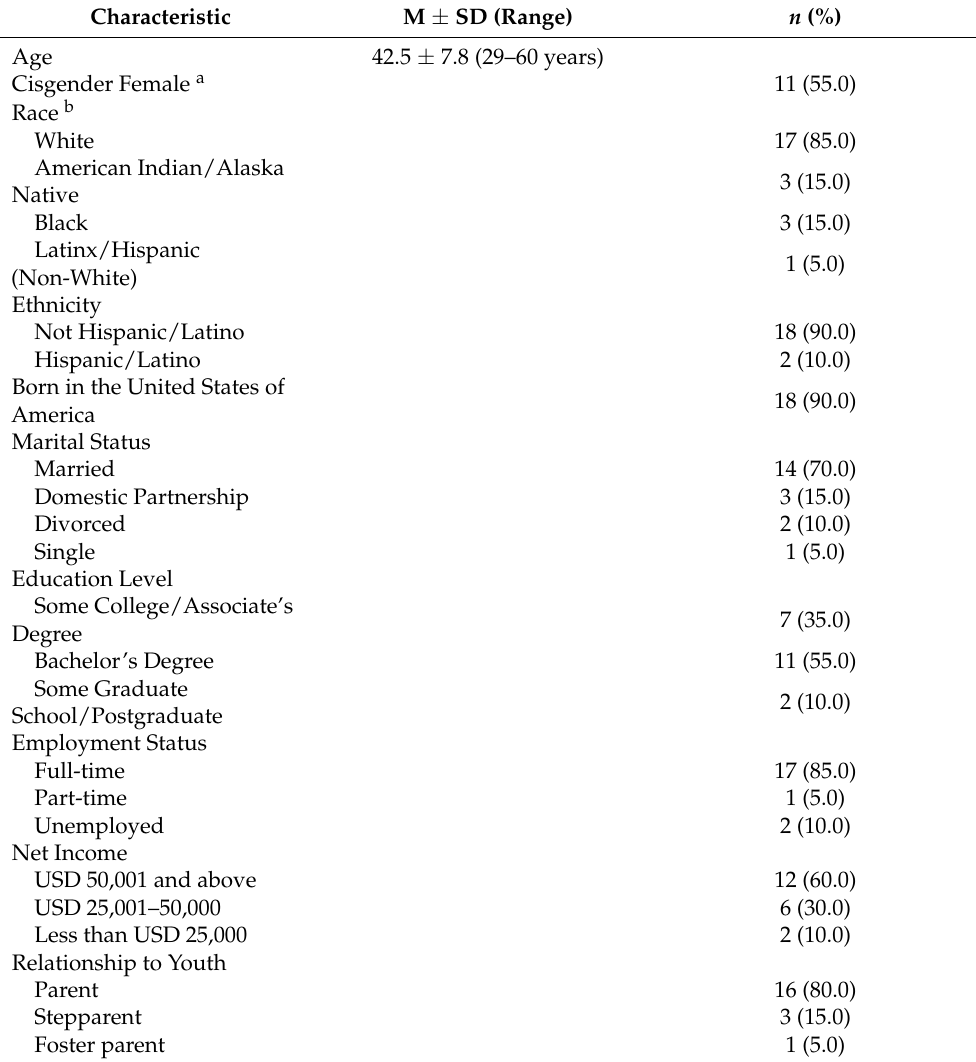
Table 1. Parent and guardian demographics ( n =